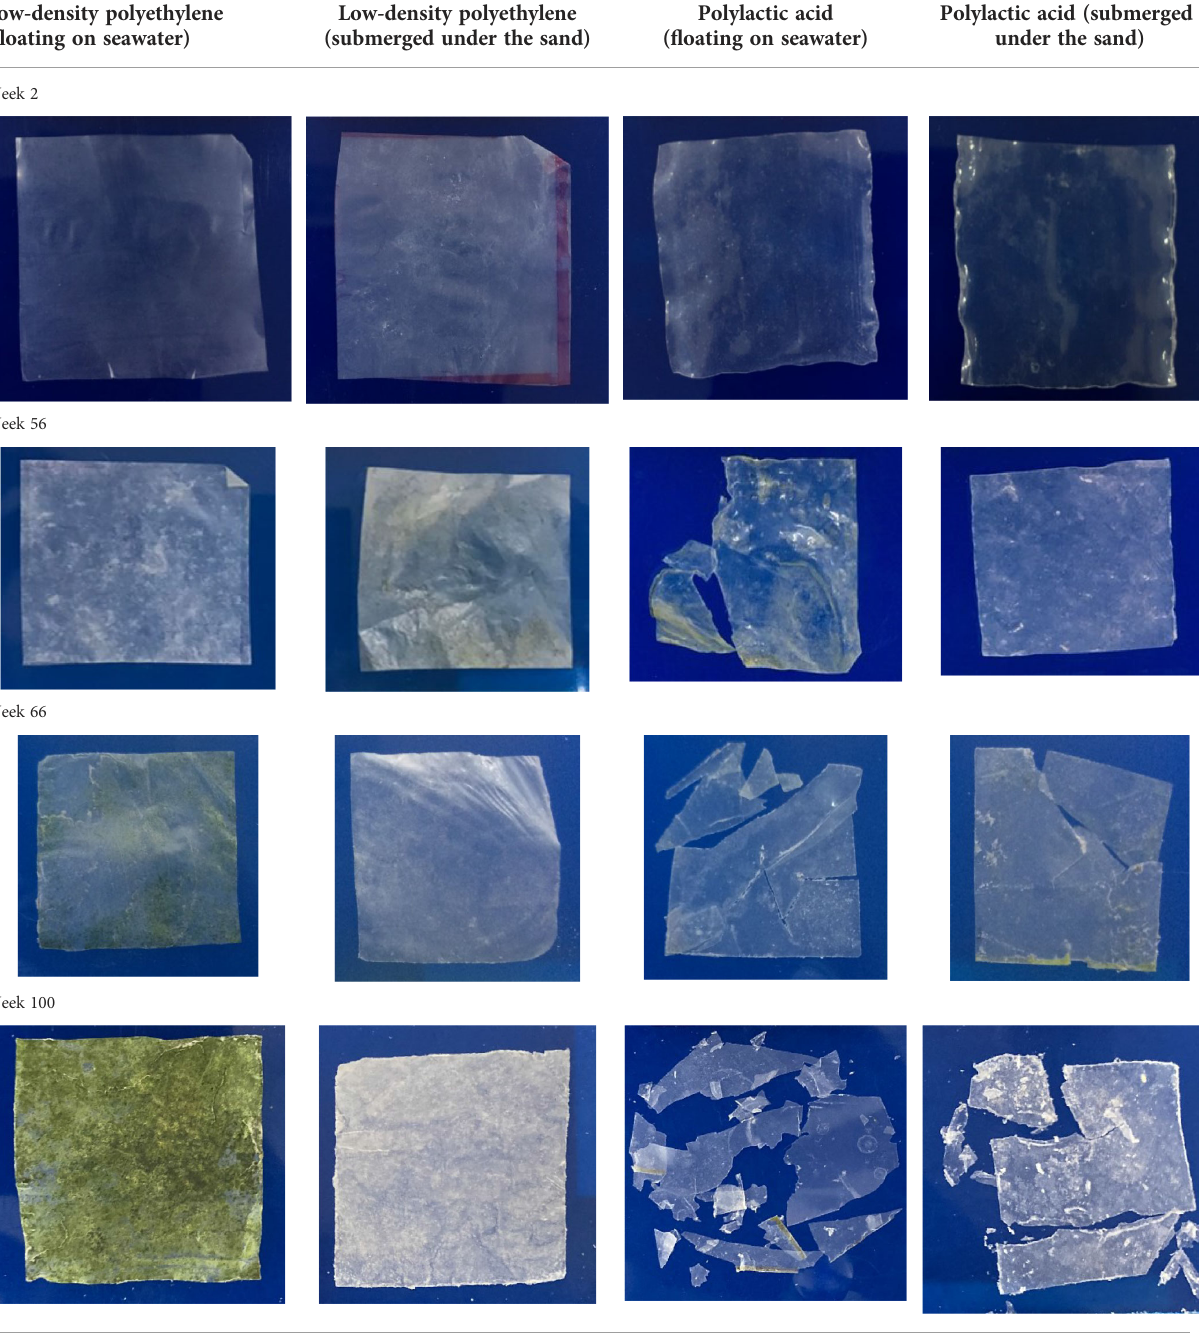
TABLE 2 Observation of blown fi lm that was fl oated on seawater surface and submerged in the sand under the seawater of low-density polyethylene and polylactic acid. Low-density